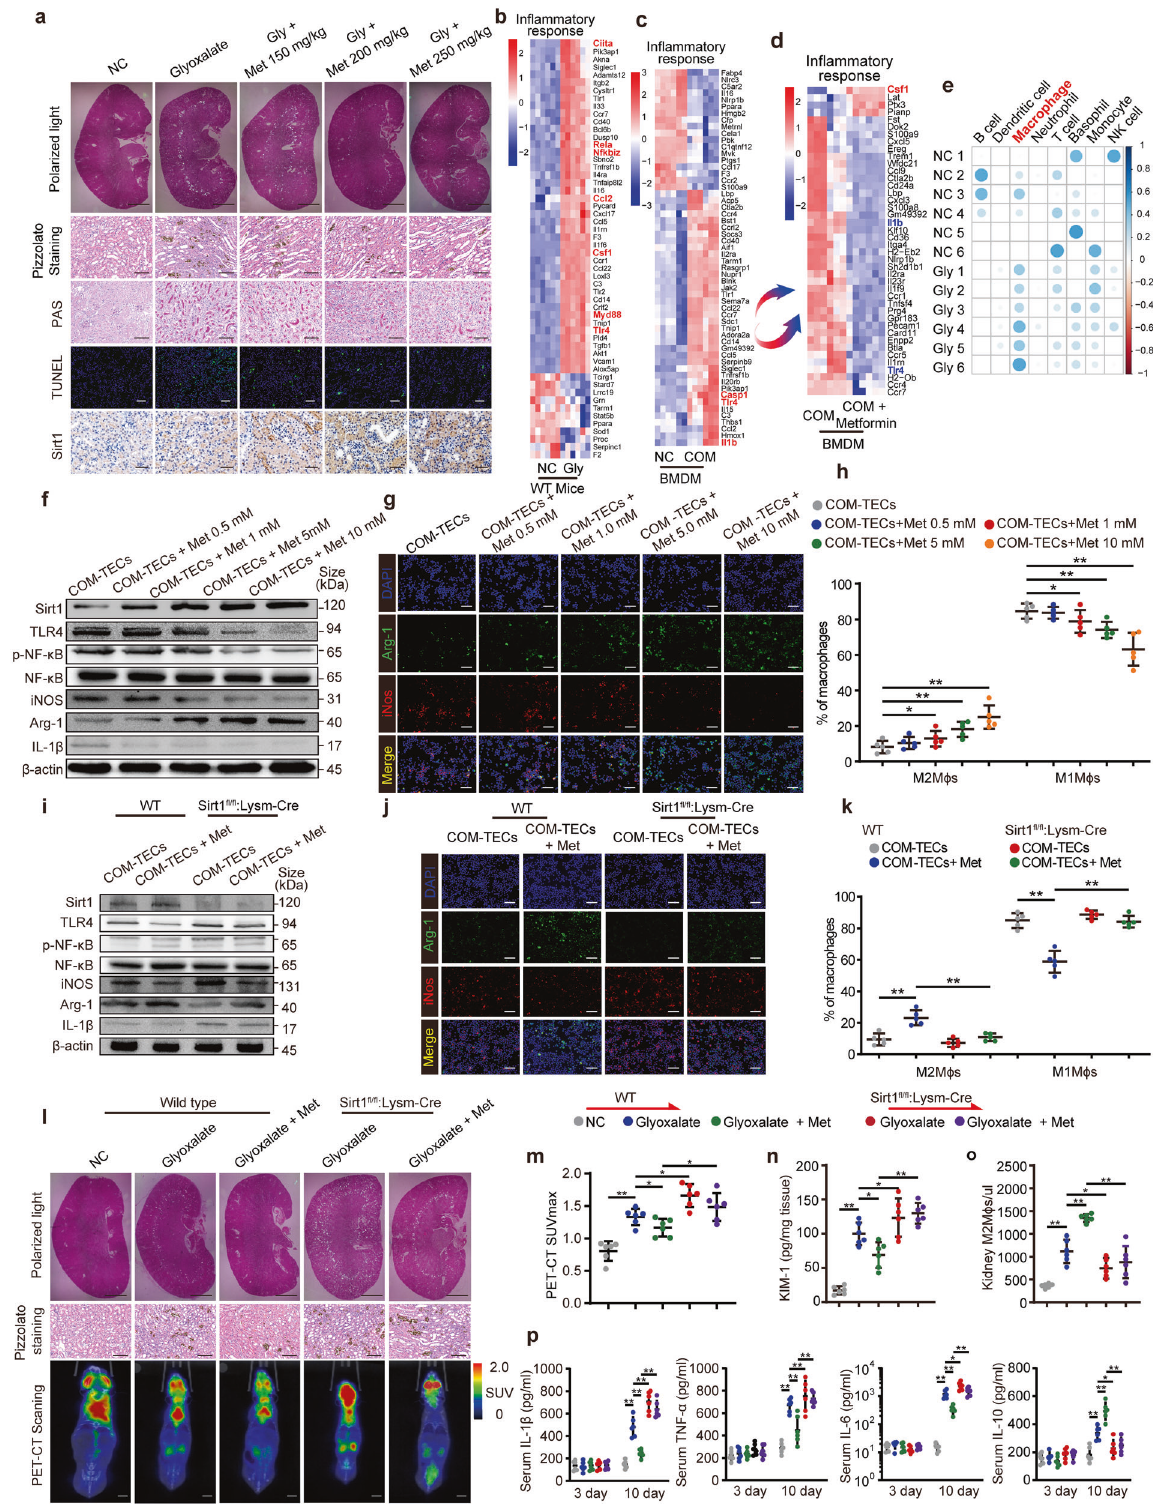
correlation coef fi cient analysis indicated a negative correlation between the expression of Sirt1 and the expression of TLR4 and IL- 1 β (Supplementary Fig. S4d, e). These data suggest that Met may abrogate CaOx-induced in fl ammatory injury through